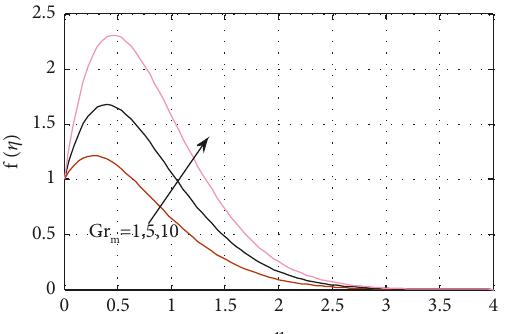
Figure 5: Impact of the nonlinear solutal convection parameter on the velocity profile using A � 1 ,v � 0 . 1 , ε � 0 . 1 , ε � 0 . 1 , β � 0 . 4 , β � 0 . 1 , β � 0 . 4 , β � 0 . 4 ,Gr 0 1 2 1 2 1 2 � 5 ,P � 4 , R � 0 . 1 ,S � 1 . 5 , c � 0 . 4. � 0 . 4. c r d c 0 1 1